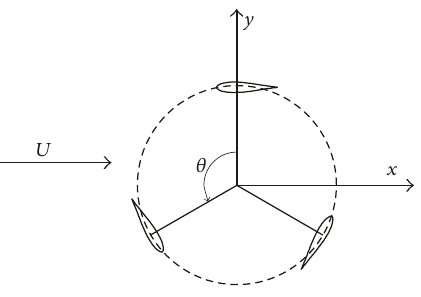
Table 1: Main features of the analyzed rotor. Figure 2: Structural parameters of wind